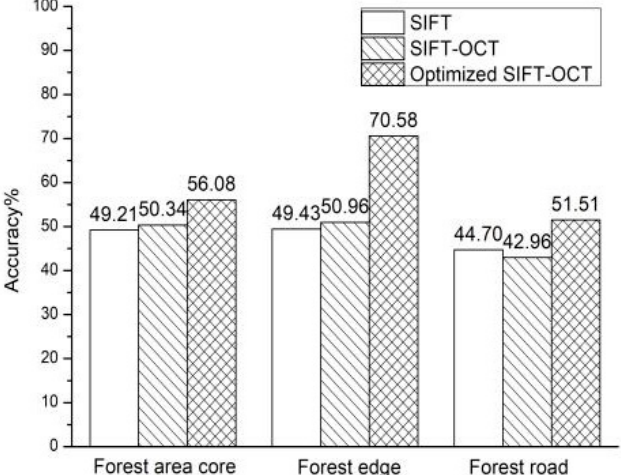
Figure 6. Matching accuracy comparison between different algorithms on different ground covers.